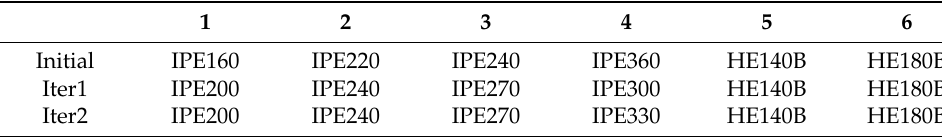
Figure 13. The layout of Frame B. Table 7. Frame B: Member sections in each iteration.